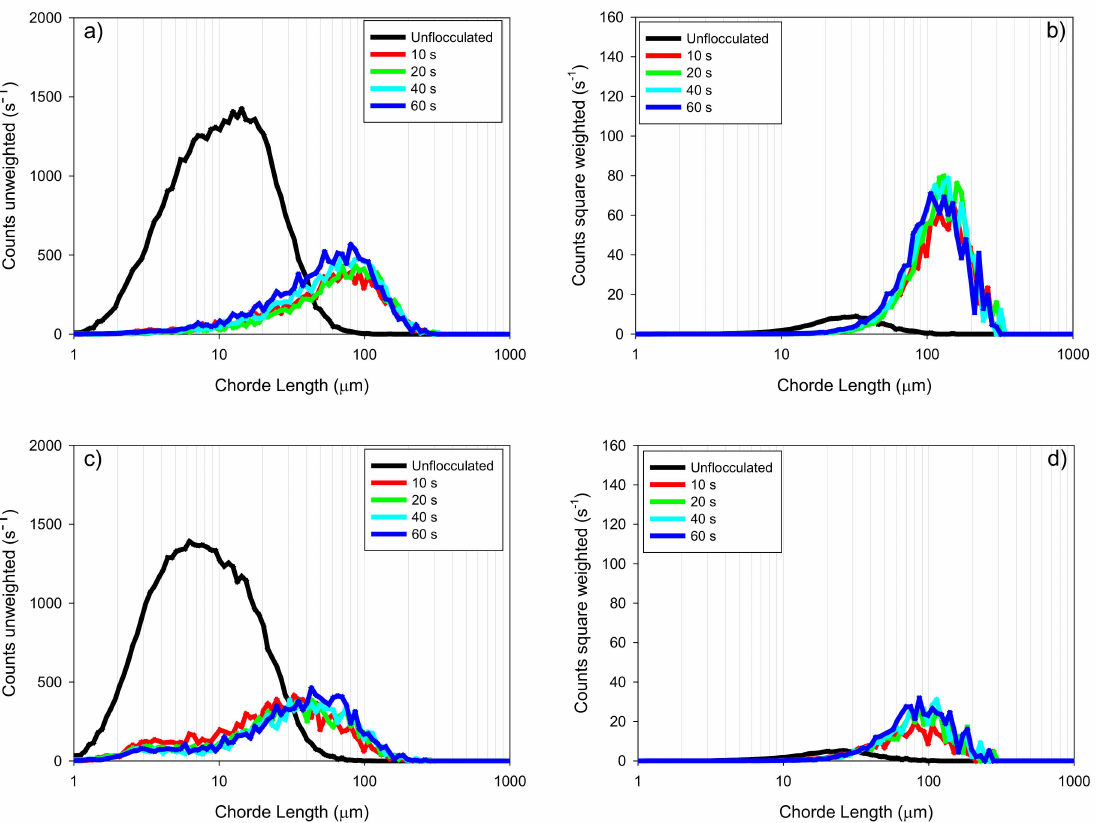
Figure 8. ( a ) unweighted CLD for MQ in SW, ( b ) square-weighted CLD for MQ in SW, ( c ) unweighted CLD for MQ in IW, ( d ) square-weighted CLD for MQ in IW. Flocculant dose 34 g/t, mixing rate 180 rpm, solids concentration 8 wt% (clay/quartz 10/90), pH 8. MQ = Na-montmorillonite/quartz, SW = seawater, IW = industrial